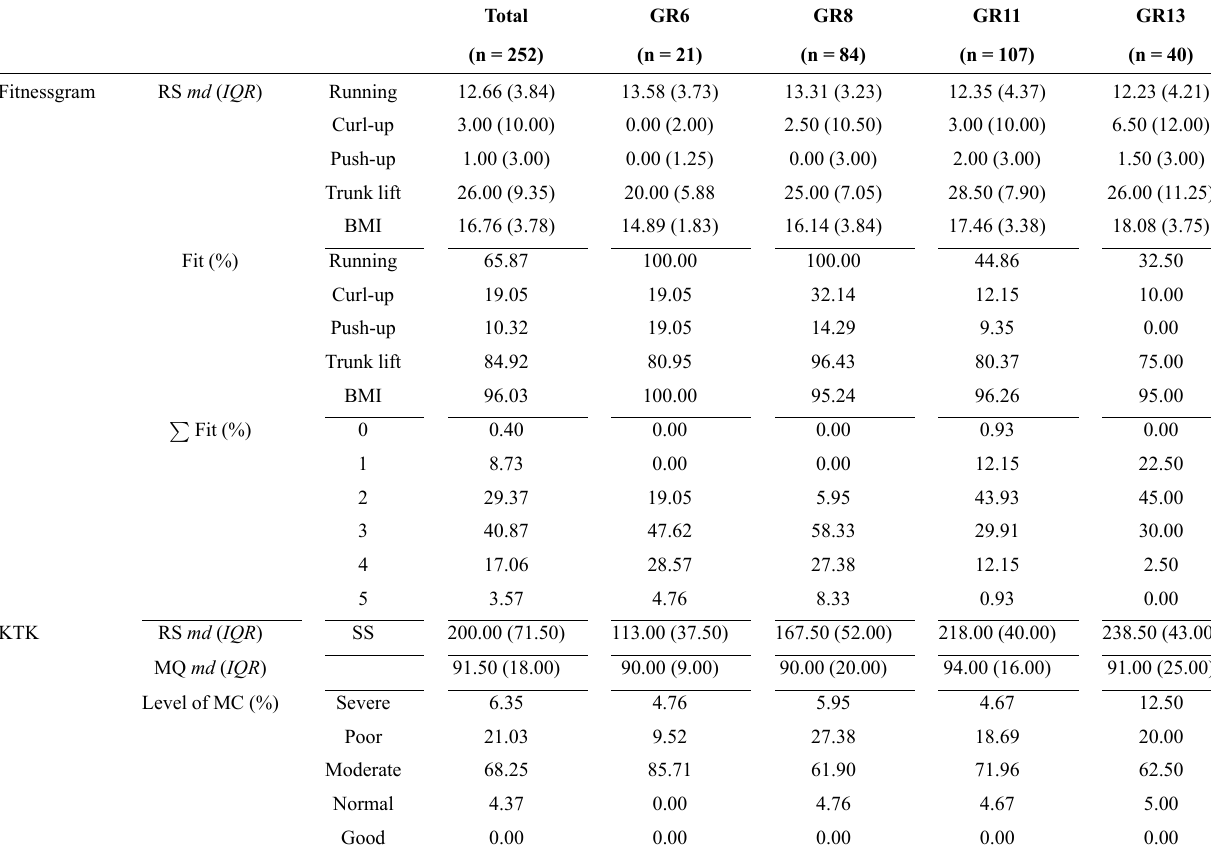
Table 2 - Girls’ sample characteristics. Raw scores for Fitnessgram and KTK, percentage of subjects rated as fit (Fit) and the sum ( test; Motor Quotient and Level of Motor Coordination.